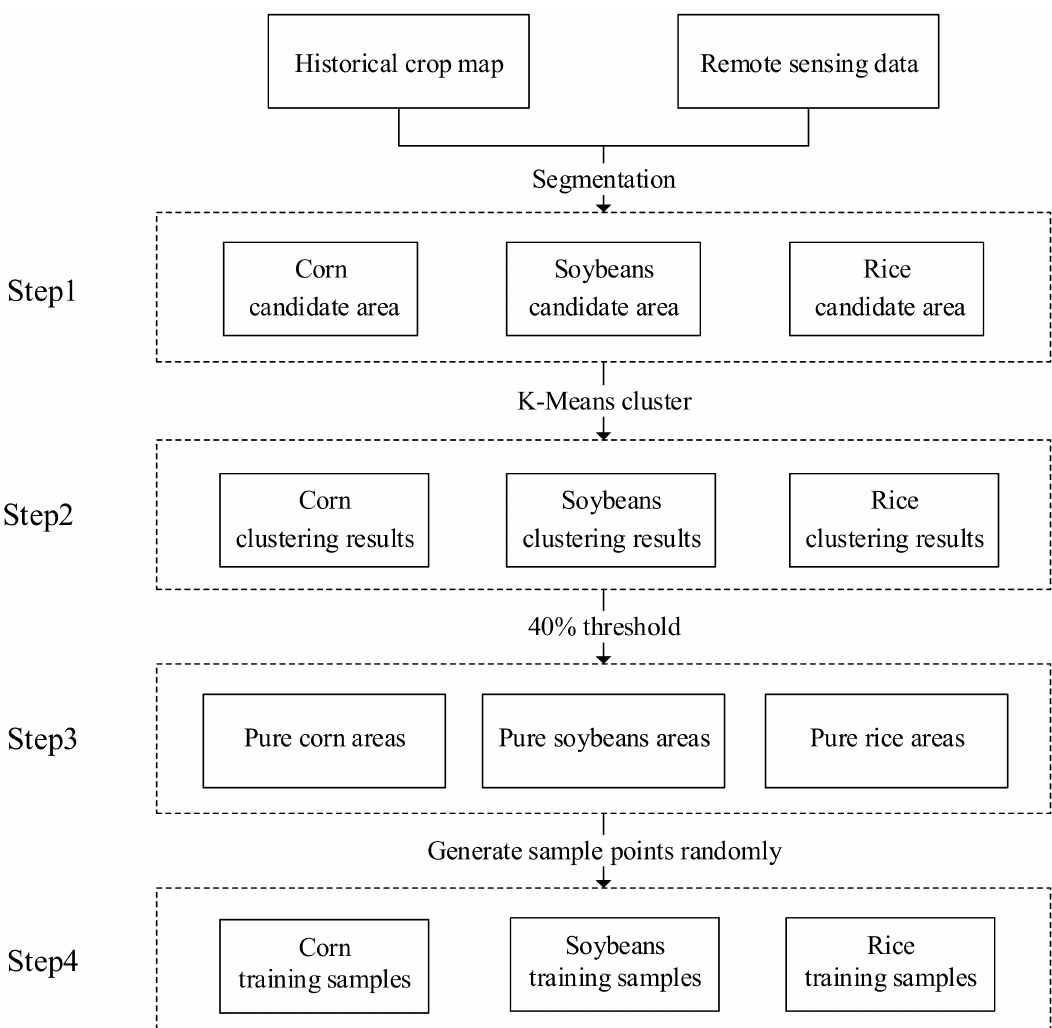
Figure 4. Technical process of automatic acquisition of training